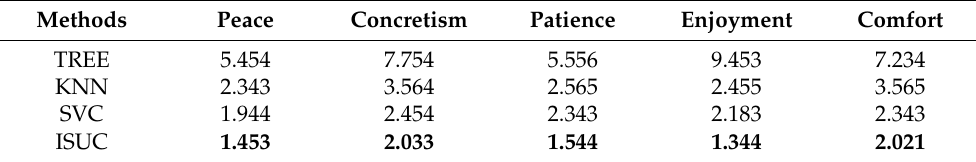
Table 2. Shows the experimental outcomes of negative feelings.